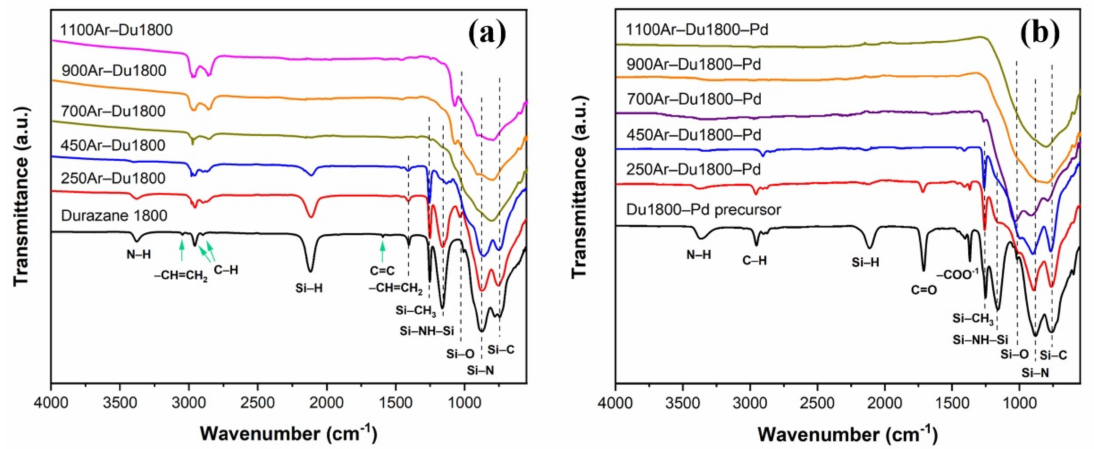
Figure 6. ATR-FTIR spectra of ( a ) Durazane 1800 and ( b ) Du1800-Pd precursor before pyrolysis, after cross-linking at 250 ◦ C for 2 h, followed by ceramization at different temperatures (700 ◦ C, 900 ◦ C and 1100 ◦ C) under argon atmosphere for 3